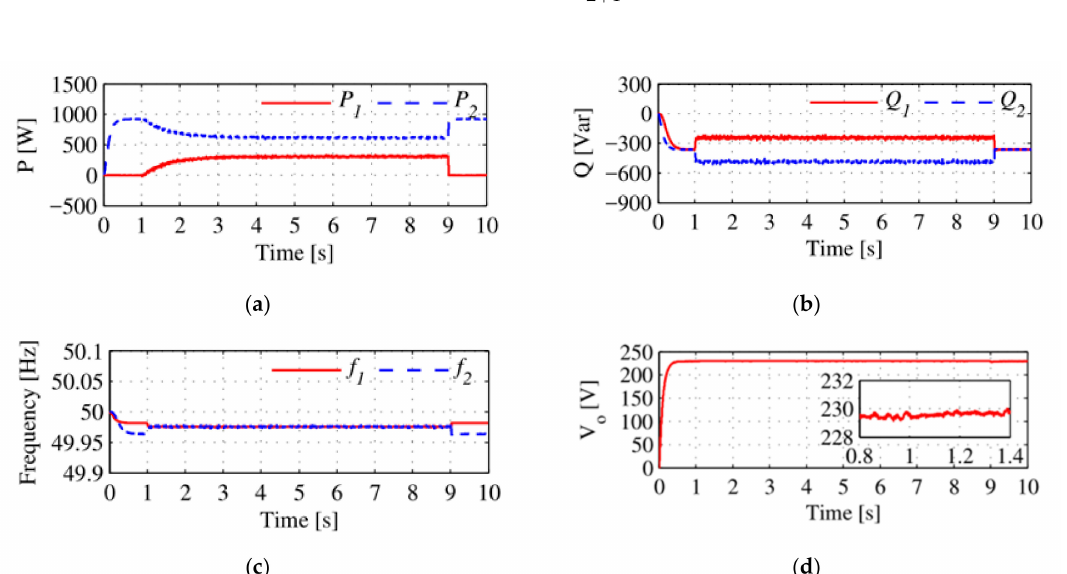
Figure 9. Power sharing in the first scenario considering resistive feeder impedance; ( a ) output active powers of DGs, ( b ) output reactive powers of DGs, ( c ) output frequencies of DGs, ( d ) terminal DGs voltage.